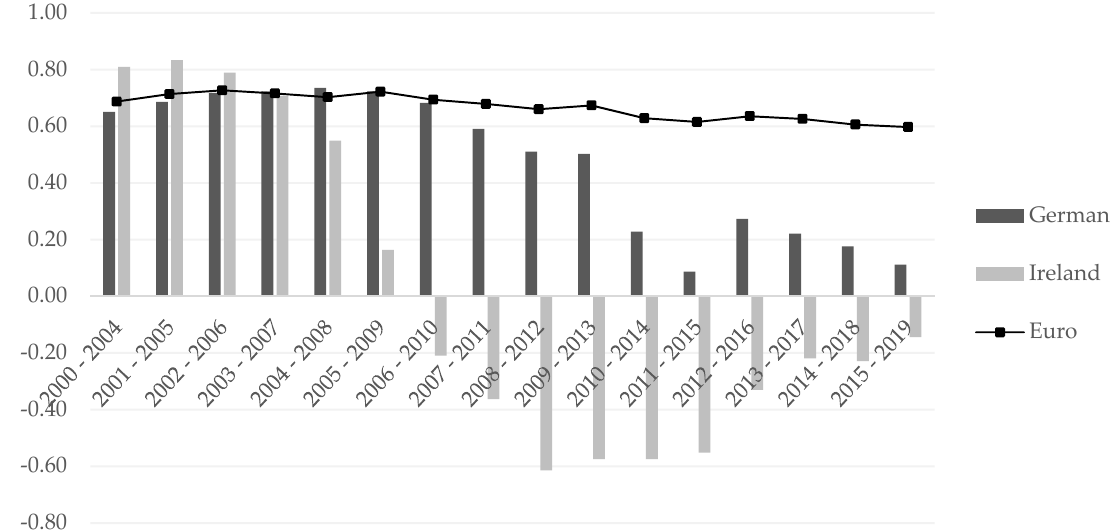
Figure 2. Correlation coefficients for productivity growth. Source: Own calculations, based on Macrobond.